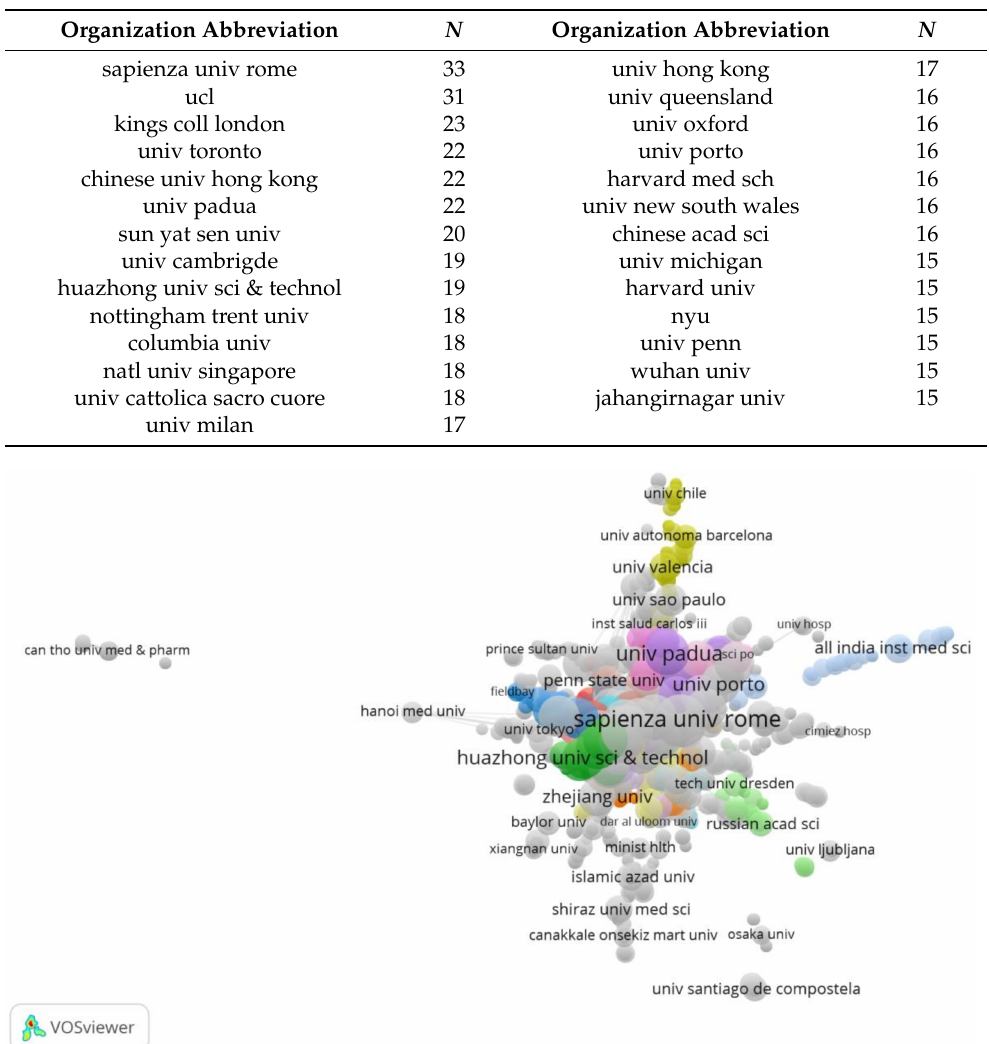
Table 4. Organizations publishing at least 10 articles.